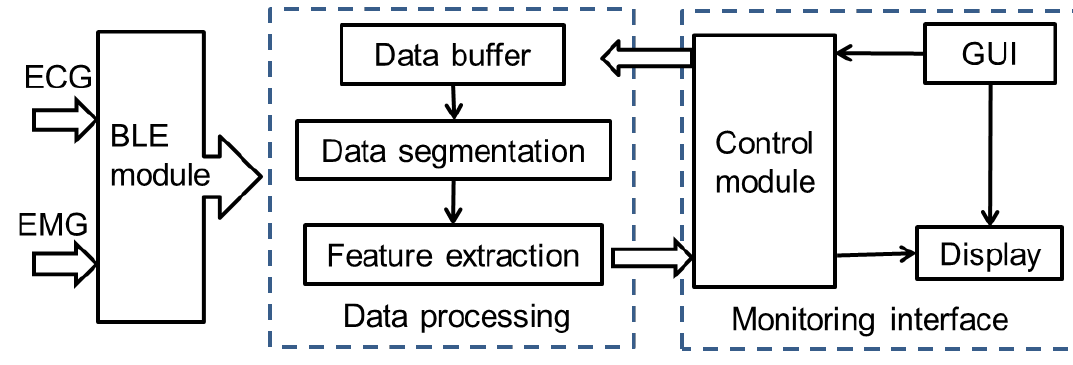
Figure 4. Software processing framework for the ECG/EMG data.